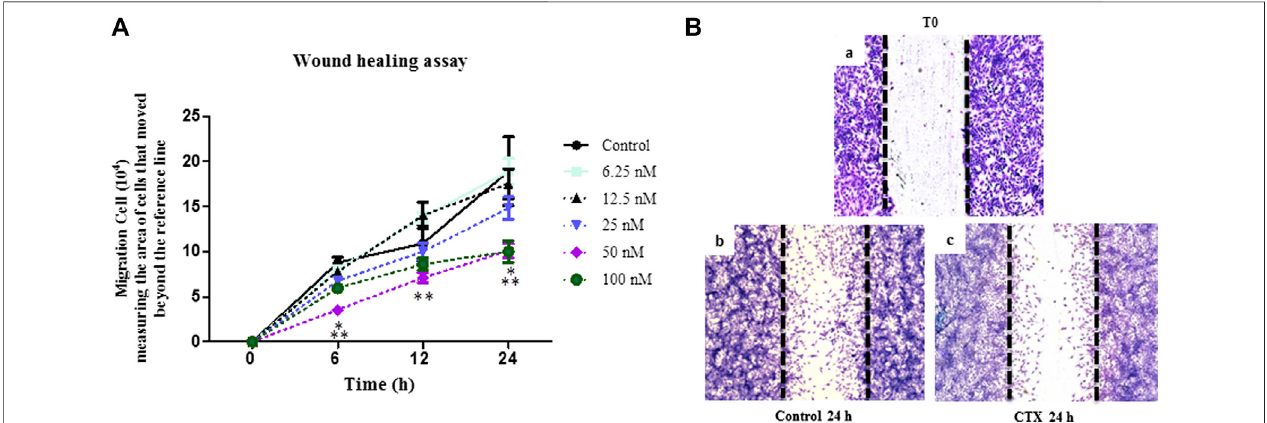
FIGURE 2 | Effect of CTX on t.End.1 migration in the Wound healing model at different treatment periods. Wound healing assay performed in t.End.1 cells treated withdifferentCTXconcentrations(6.25,12.5,25,50,100and200 nM)for0,6,12and24 hat37 ° Cand5%CO 2 . (A) ResultsareexpressedasNumberofMigratedCells and represent themean ± s.e.m. Thedataarepresentedfromthreedistinctexperiments runinatleastintriplicateeach group. * p < 0.05compared tothecontrolgroup, ** p < 0.05 compared to other CTX concentrations. (B) Photomicrographs obtained at time 0 and 24 h at × 10 magni fi cation. The images were collected under an Olympus BX 51 microscope, using the Image-Pro Plus 5.1 software, in a × 10 objective.